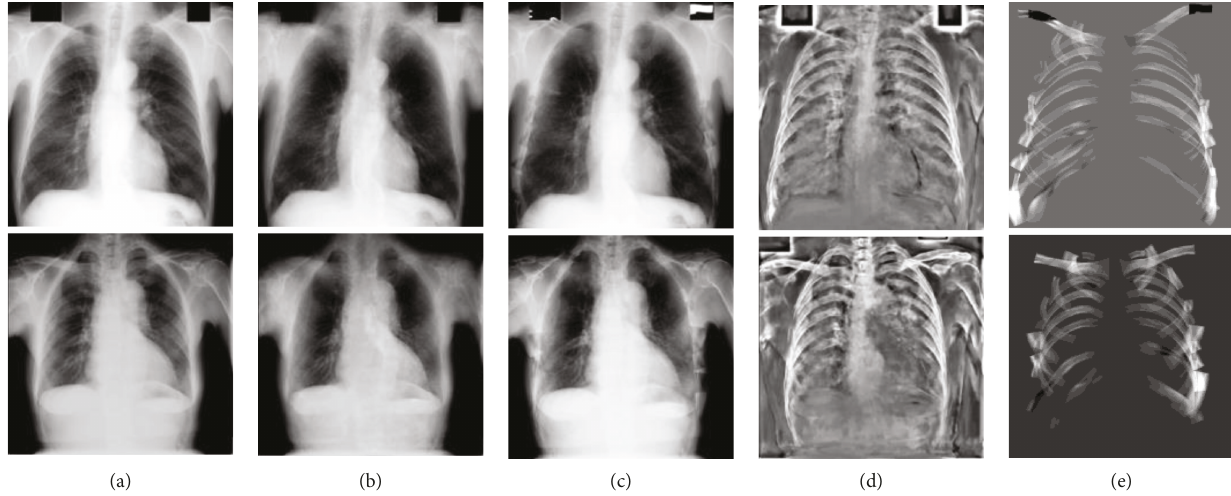
Figure 11: Decomposition results of two chest radiographs from the JSRT data set: (a) the original chest radiographs ( “ JPCLN063 ” and “ JPCNN071 ” ); (b) the reconstructed soft tissue images by the use of our method; (c) the bone-suppressed images by the use of the gradient modi fi cation method; (d) the reconstructed bone images by the use of our method; (e) the estimated bone structures by the use of the gradient modi fi cation